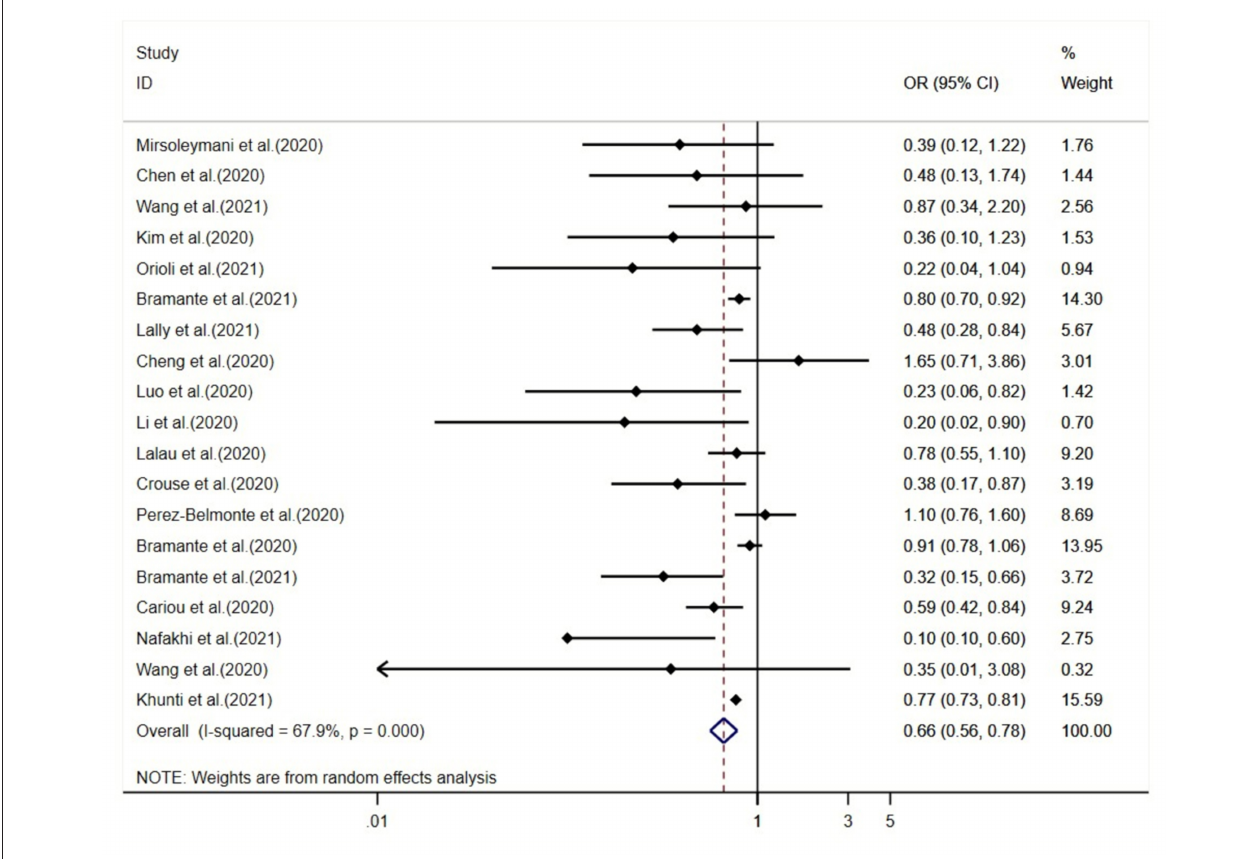
FIGURE 1 | Forest plot of studies assessing association between metformin use and mortality among COVID-19 patients. CI, confidence interval; OR, odds